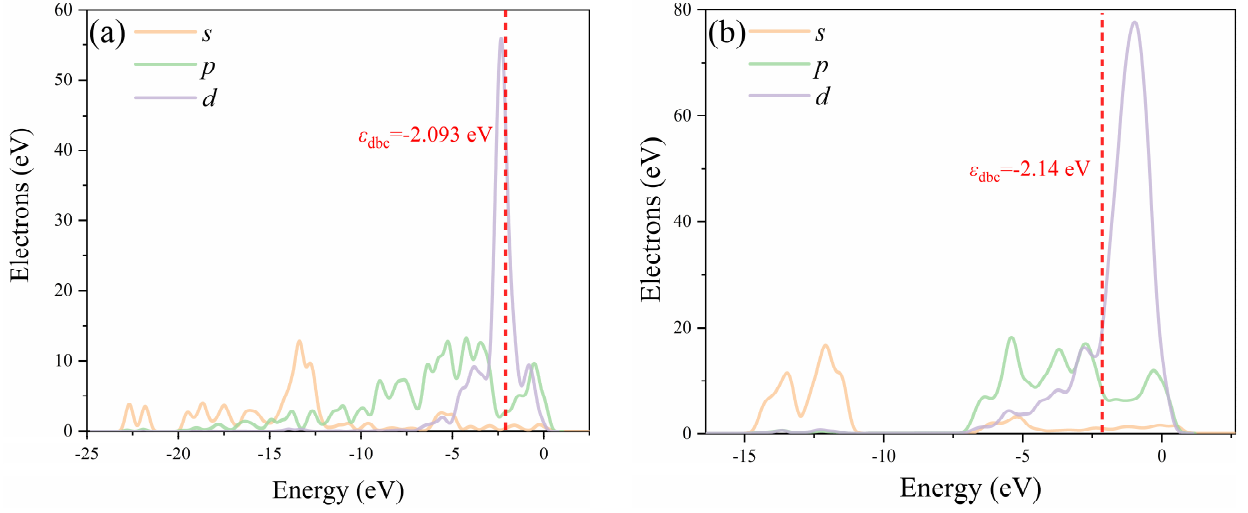
Figure 8. ( a ) CS/yNC@X density of states diagram, ( b ) CoSe density of states diagram. Through the calculation of the differential charge of the material, a section perpen- dicular to the heterojunction material is constructed along the A B direction, and the heterostructure model constructed by Materials Studio and the section diagram of the average differential charge density of the material along the Z direction are